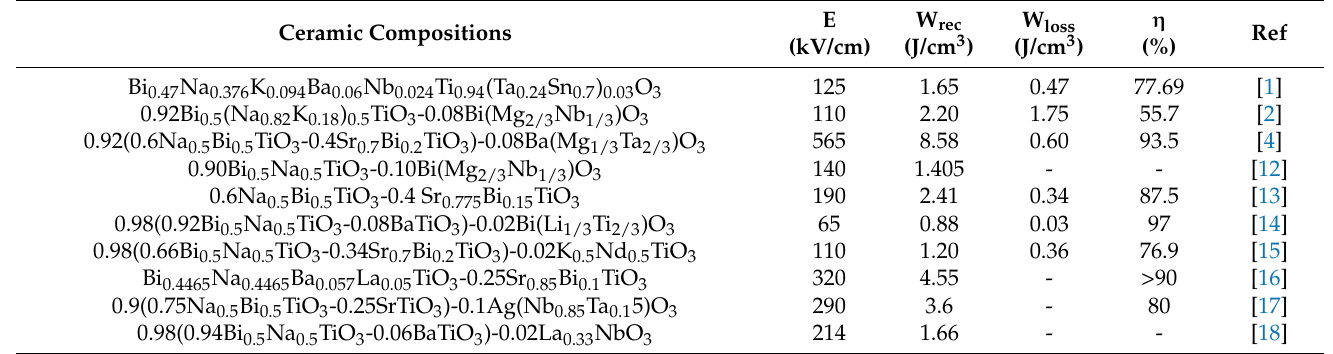
Table 1. ESP of BNT-based ceramics by solid solution modification.